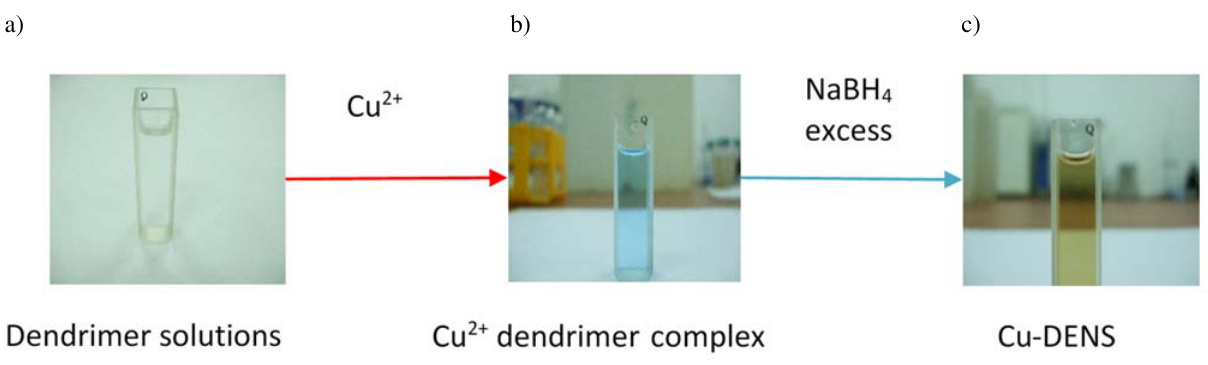
Figure 6. Change in color during the synthesis of Cu-DENs. (a) aqueous dendrimer solutions, (b) Cu 2+ dendrimer complex solution, (c) Cu-DENs solution.